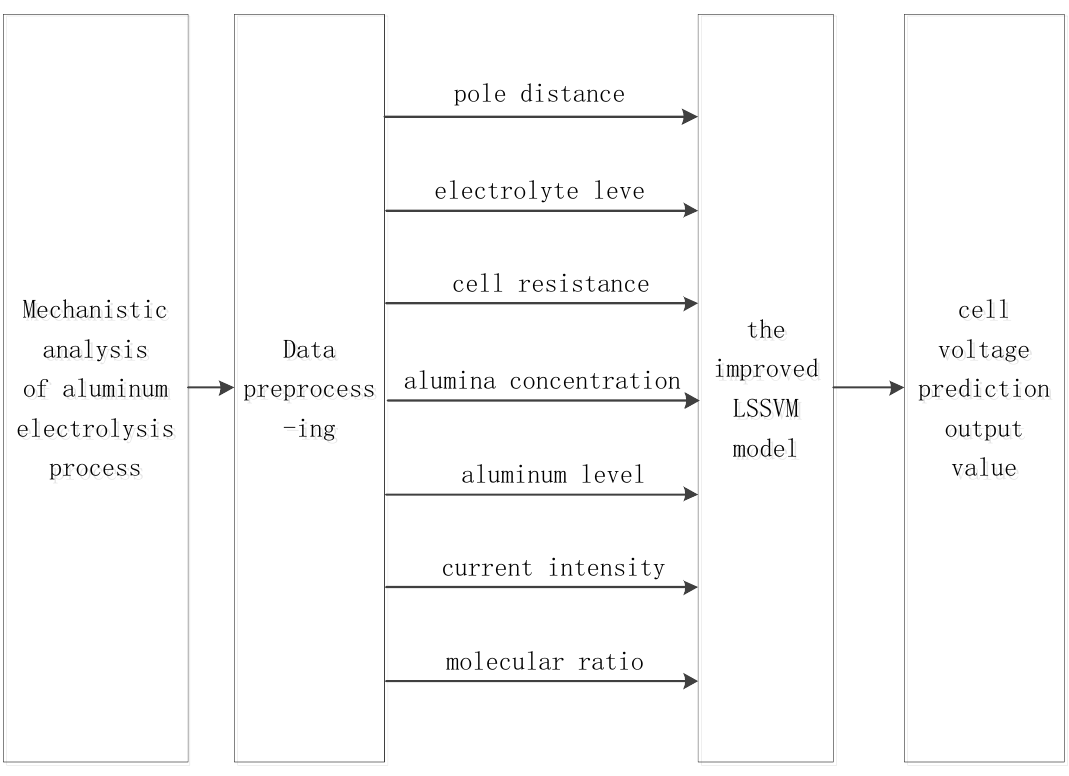
Figure 2. The schematic of aluminum electrolyzer voltage prediction.